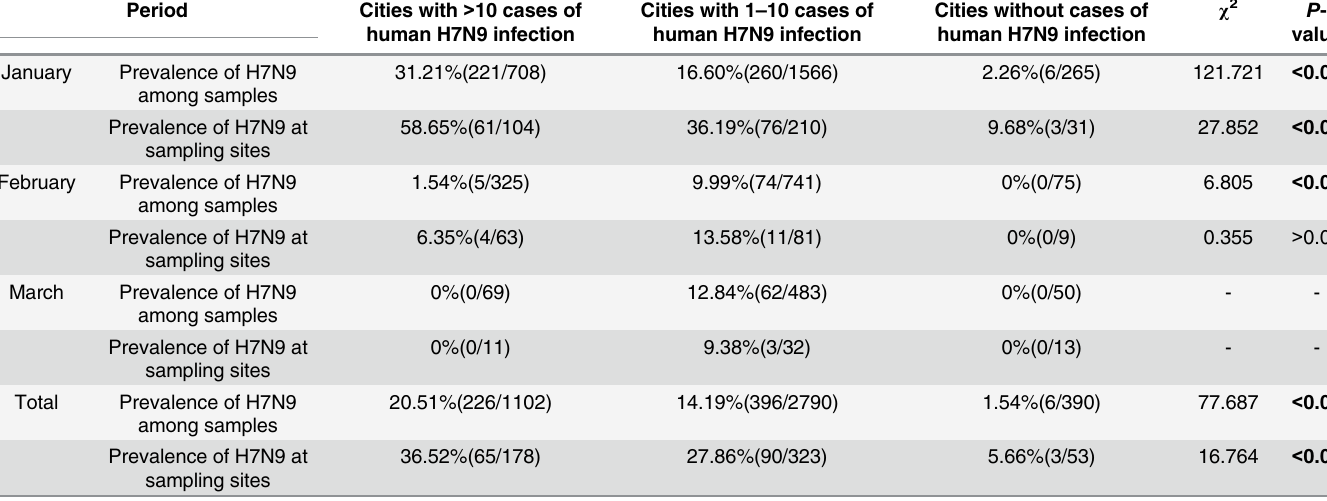
Table 4. Prevalence of H7N9 rates among samples and sampling sites from cities in Zhejiang